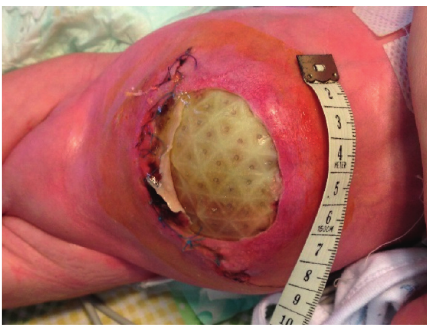
Figure 3: Skin necrosis with wound dehiscence and exposure of the Gore-Tex